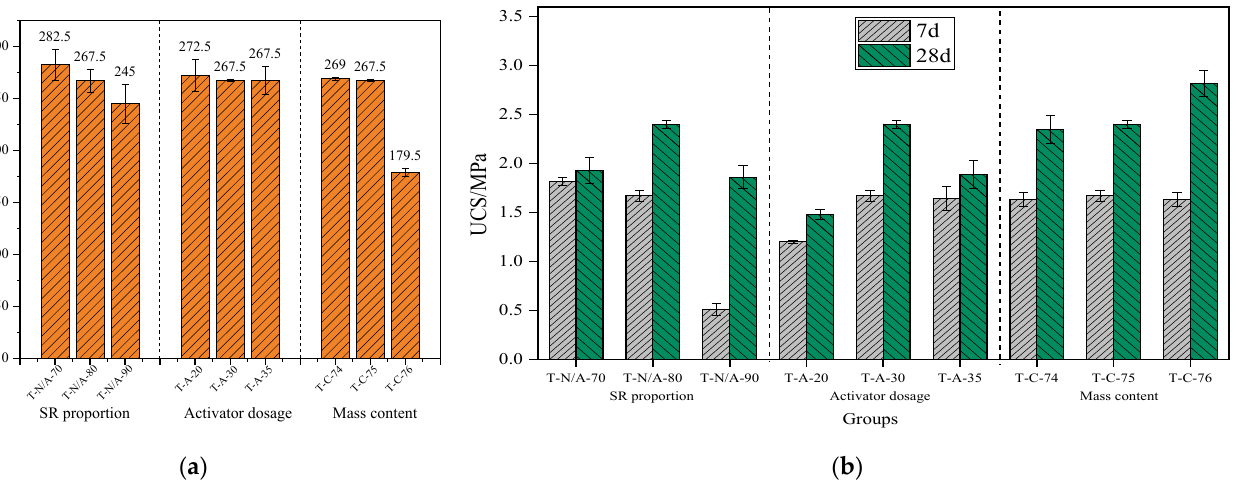
Figure 7. The influence rule of SR proportion, Activator dosage, and M ass content on the fluidity ( a ) and UCS ( b ) of CPB specimens.